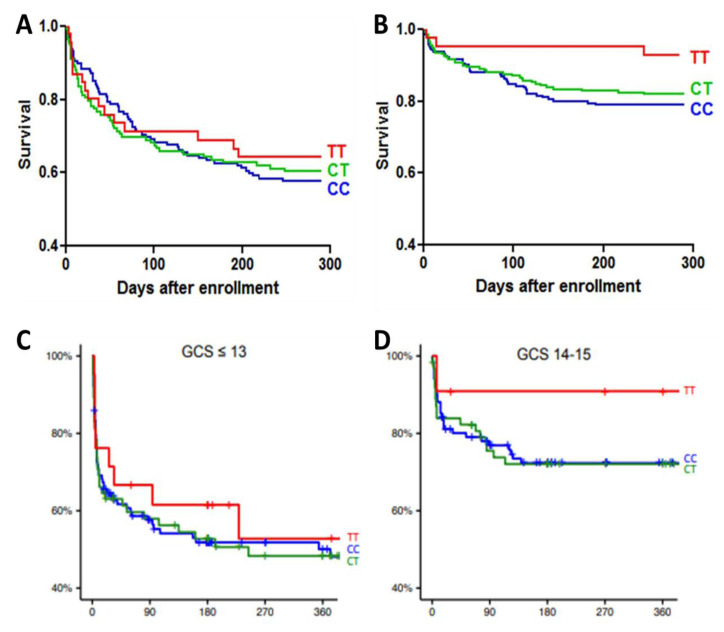
Kaplan-Meier survival curves stratified by LTA4H genotype.Figures
A and
B show survival in 763 patients with tuberculous meningitis in Vietnam
16, with human immunodeficiency virus (HIV) infection (
A), and without HIV infection (
B). In HIV-infected patients, case-fatality rates were 34.8% (16 of 46) in those with TT genotype, 42.1% (61 of 145) in CT genotype, and 38.8% (52 of 134) in CC genotype. In HIV-uninfected patients, case-fatality rates were 7.1% (3 of 42) in TT, 21.4% (40 of 187) in CT, and 18.7% (39 of 209) in CC. Figures
C and
D show survival in 375 patients with tuberculous meningitis in Indonesia
19. These patients are HIV-uninfected with severe (GCS ≤ 13) (
C) or milder (GCS 14–15) disease (
D). In a recessive model, TT genotype versus CT/TT combined had HR 0.81 (95% CI 0.41-1.62, p = .550) in severe and 0.31 (95% CI 0.04-2.25, p = .156) in milder disease.